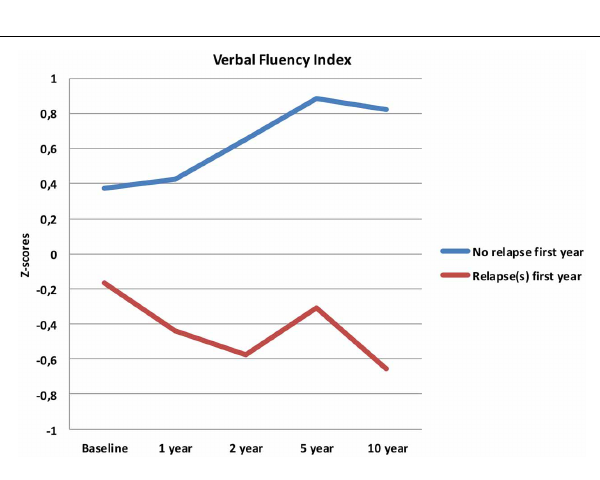
FIGURE 3 | Verbal Fluency index from baseline to 10 year follow-up, split by early